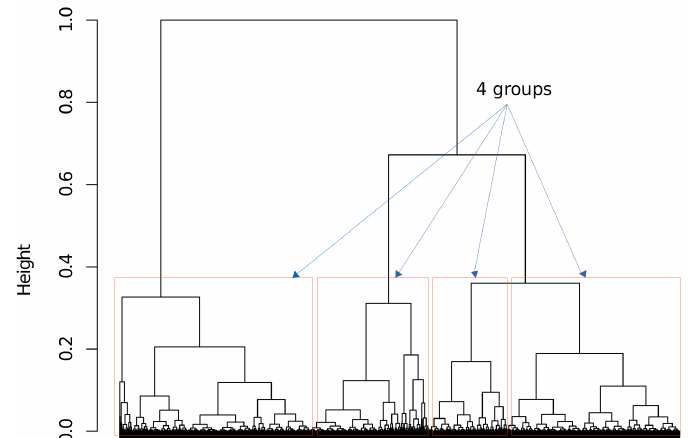
Figure 3. Dendrogram of SNR and channel